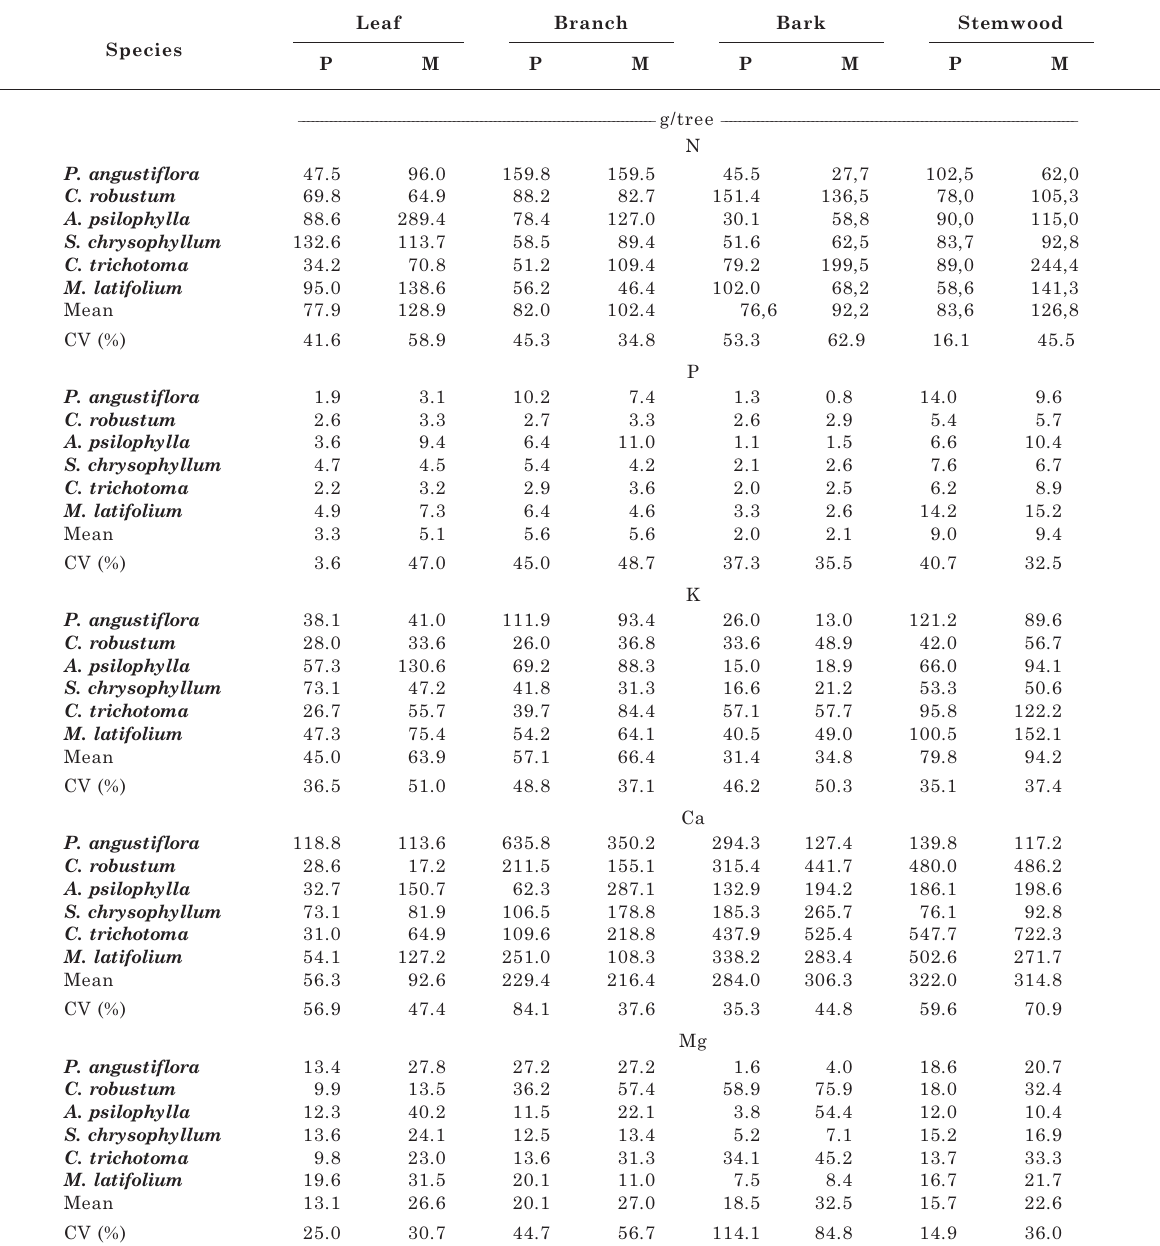
Table 4. Nutrient accumulation in the above-ground components of native forest species, in pure (P) and mixed (M) stands